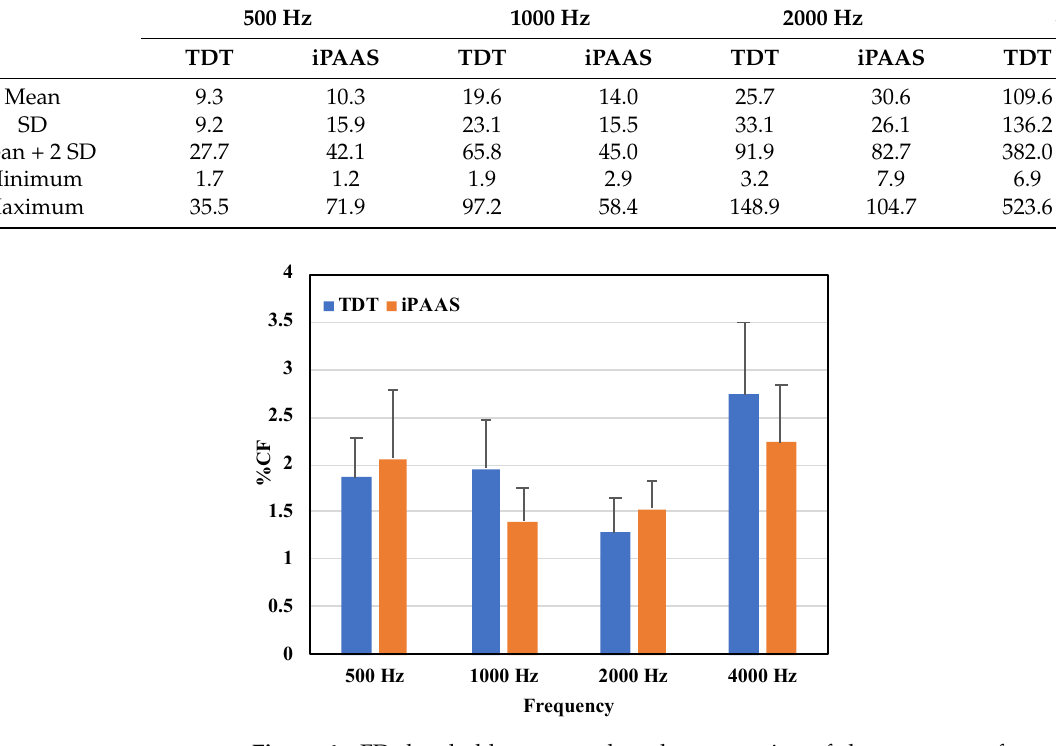
Figure 4. FD thresholds expressed as the proportion of the test center frequency in % for the laboratory-based system (TDT) and iPAAS system. FD thresholds are shown in blue color and orange color for TDT and iPAAS systems, respectively. The error bars represent the standard error of the mean.